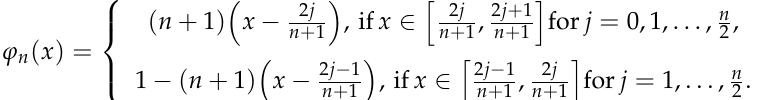
Figure 30. The map f 4 and the ω -limit set ω F